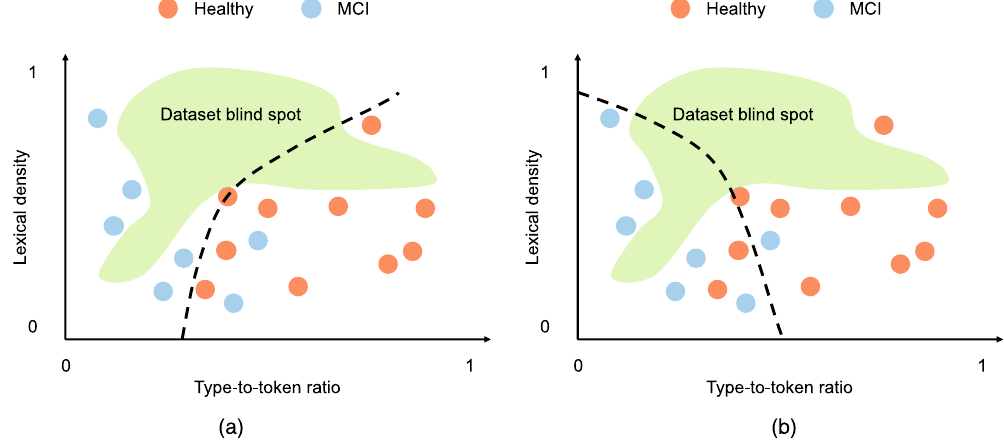
Fig. 3 Two classi fi ers learned from the 2-d samples in Fig. 2. Both classi fi ers achieve approximately the same performance on the available data; however they would treat most of the samples from the blind spot differently. Model a would classify them as MCI, whereas model b would classify them as healthy.